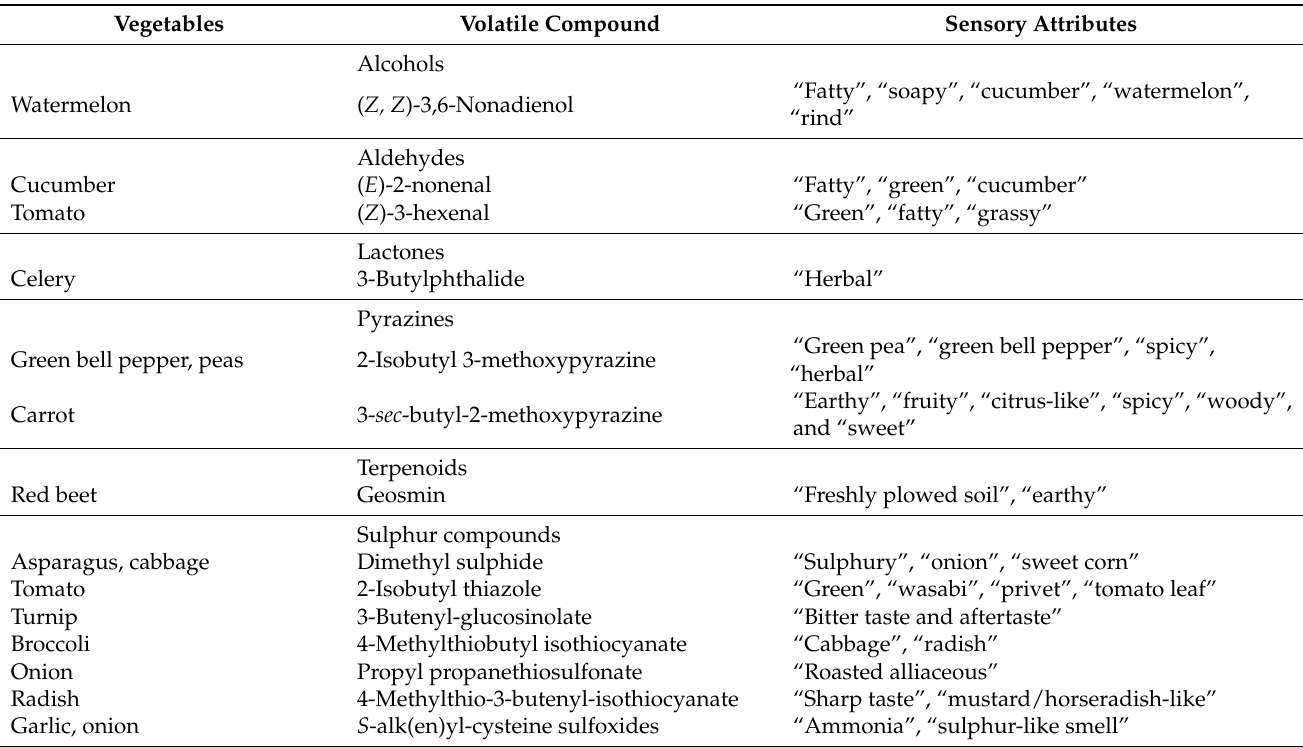
Table 5. The key role of some volatile compounds responsible for the sensory attributes of some vegetable species adapted from Parker et al. [126] and Maarse [134]. In Table 5 are some examples of compounds responsible for typical sensory attributes found in vegetables.